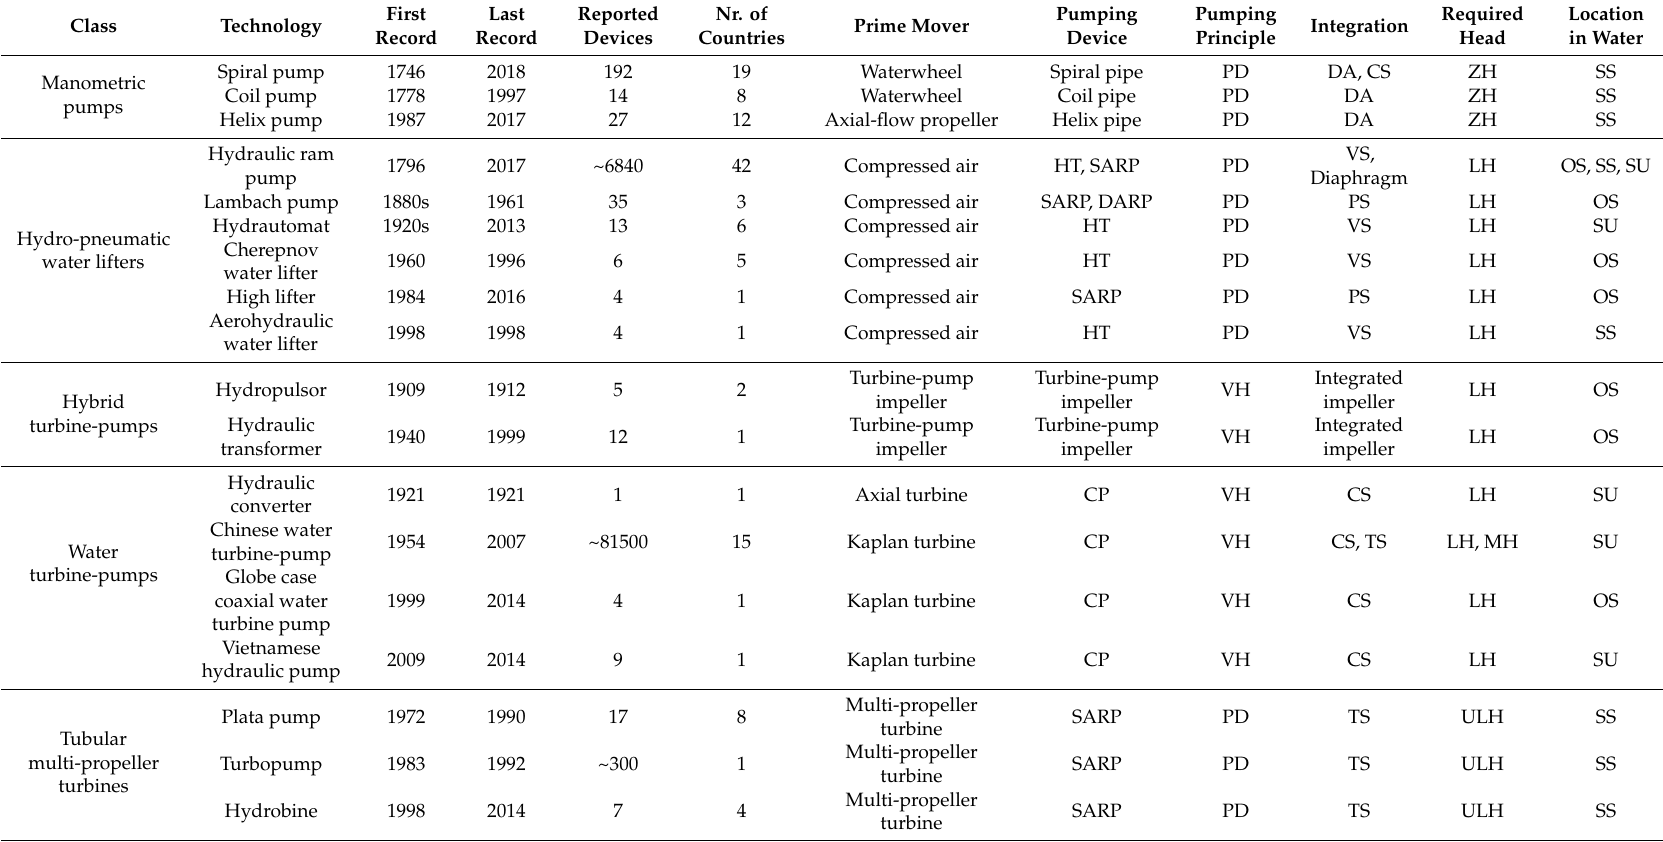
Table 1. Summary of HPP